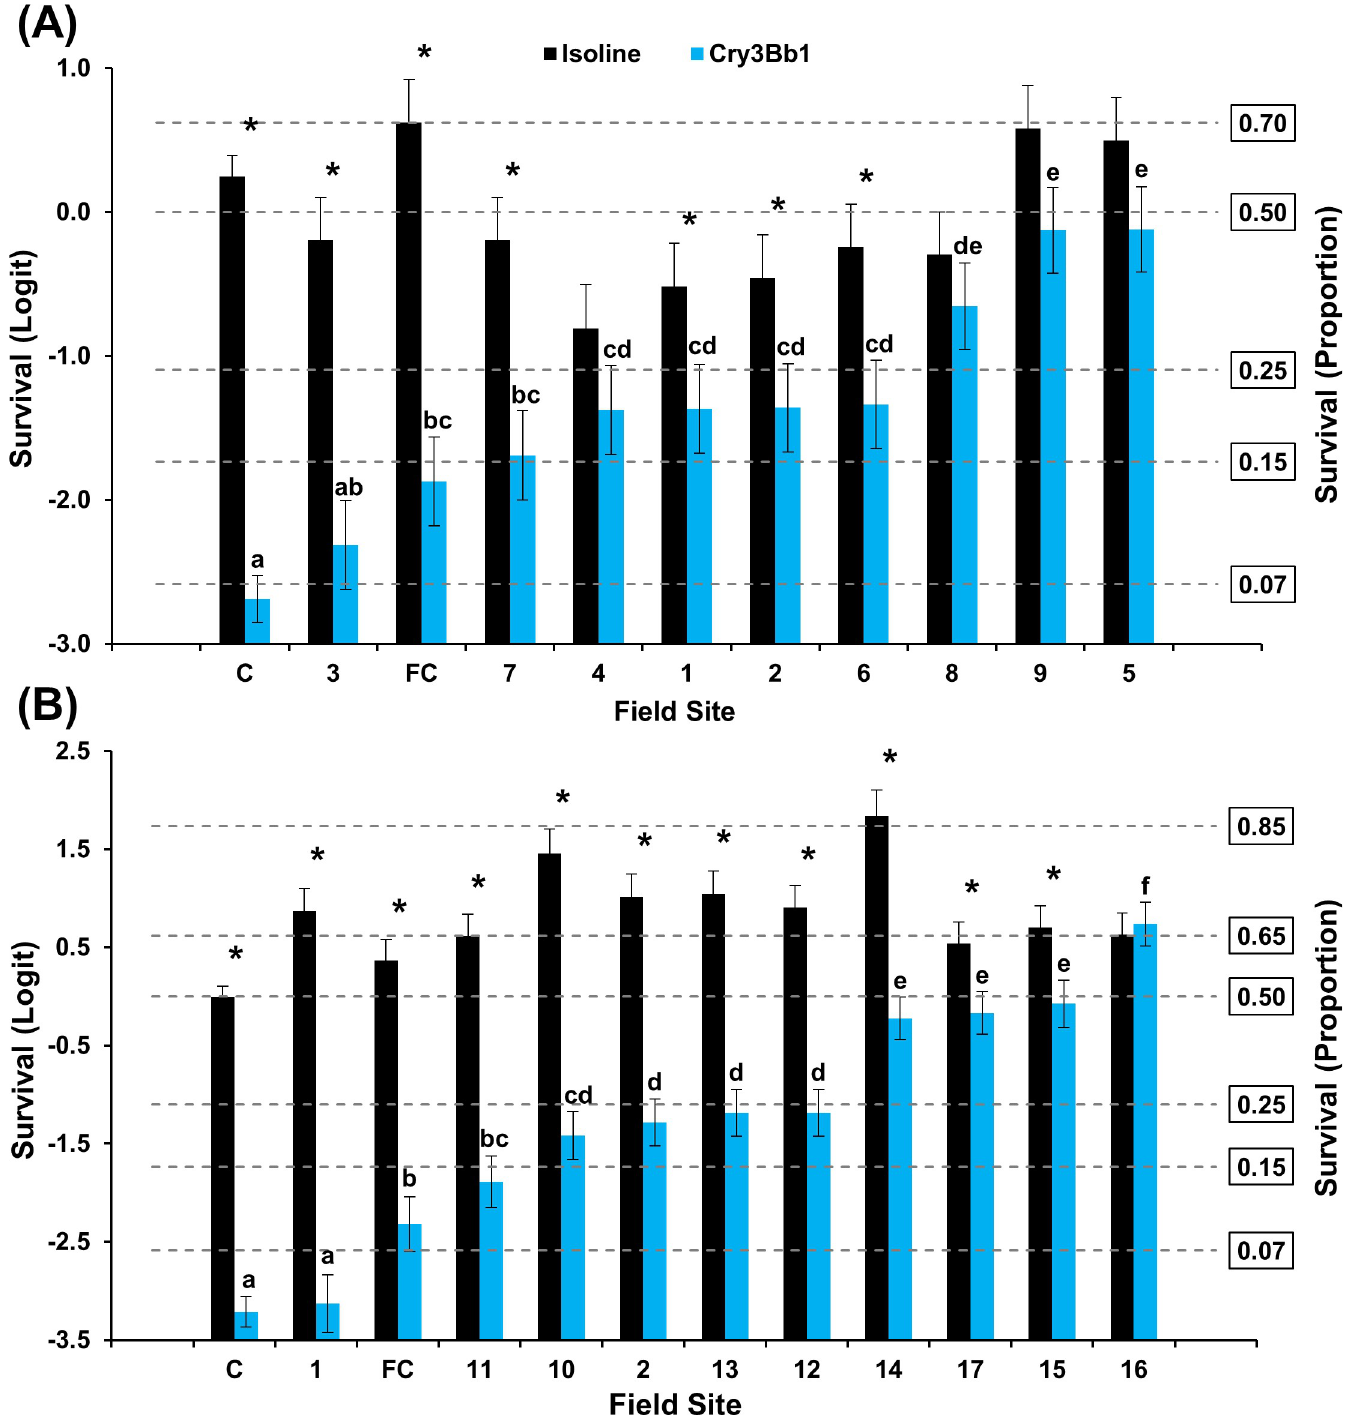
Fig 2. Mean WCR larval survival ( ± SE) of Keith County populations on Cry3Bb1 and its isoline. (A) 2016 bioassays. (B) 2017 bioassays. C = composite lab control; FC = field control. � indicates significantly higher survival on isoline compared to Cry3Bb1. Within years, Cry3Bb1 means with the same letter were not significantly different (generalized linear model, P > 0.05; LSMEANS